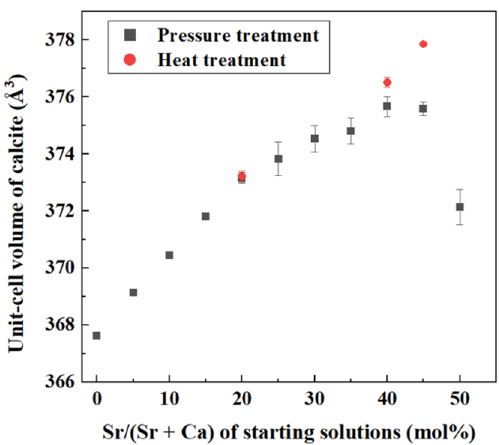
Figure 2. Unit-cell volume of calcite samples obtained from heating treatment and pressure treatment vs. Sr/(Sr + Ca) of starting solutions. The sample with the largest volume higher than 377 Å 3 contained strotntianite. The error bar was derived from standard deviation of unit cell volume estimated using general structure analysis system (GSAS).